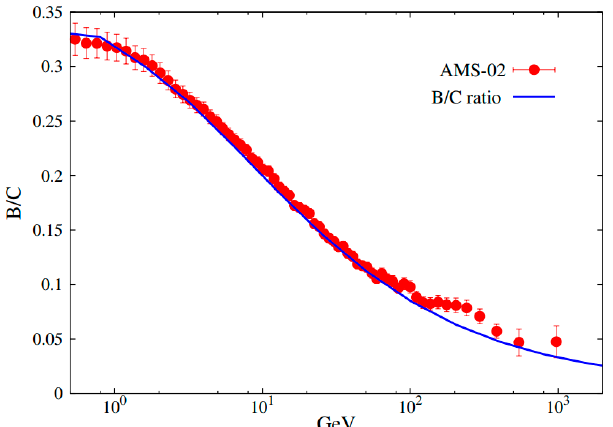
Figure 1. Fitting to B/C ratio with the Model prediction. The B/C data points are taken from the AMS-02 experiment [69]. Table 1. Transport parameters of SDP model.